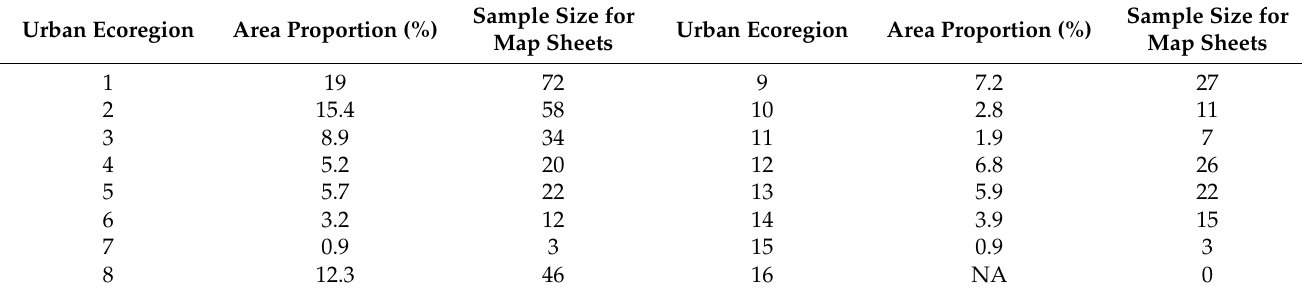
Table 4. The sample sizes for the map sheets of the global urban land-cover product in each urban ecoregion (1 – 16 denote the index of the urban ecoregions corresponding to Figure 7).